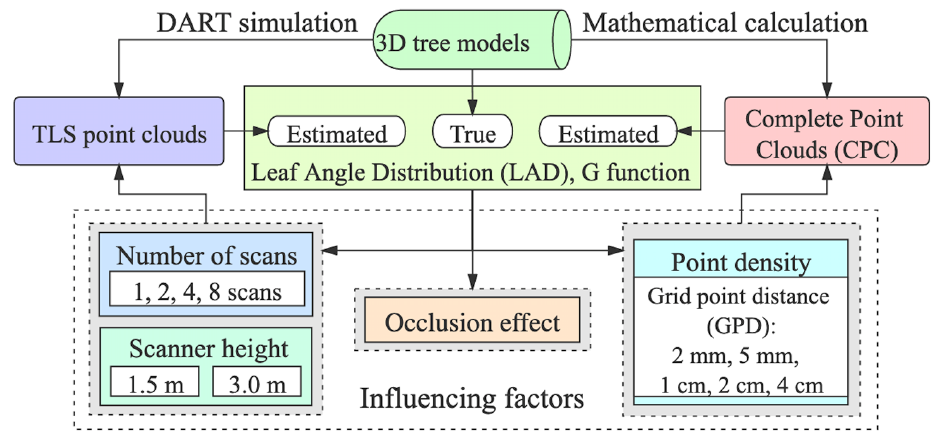
Figure 2. Schematic diagram of the materials and methods. See Section 2.1 for details of the “3D tree models” and “terrestrial laser scanning (TLS) point clouds”, Sections 2.2 and 2.3 for the leaf angle distribution (LAD) and G-function calculation, Section 2.4 for the “Complete Point Clouds (CPC)”, and Section 2.5 for the “Influencing